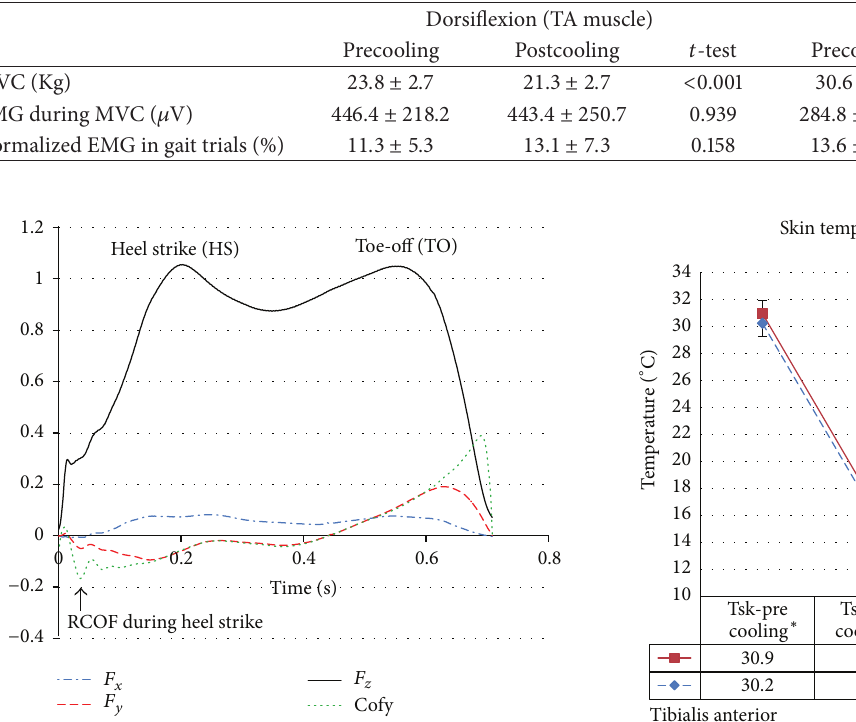
Figure 6: Mean skin temperature over the two muscles (TA and GM) for four measurement phases. Tsk-pre: before cooling, Tsk- post cooling 1: immediately after cooling, Tsk-post cooling 2: after the postcooling MVC test, and Tsk-post cooling 3:end of gait